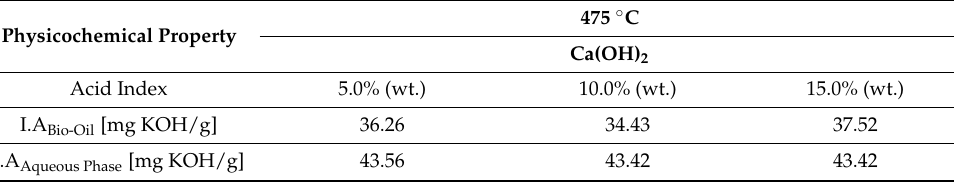
Table 12. Effect of Ca(OH) 2 content on the acid index of bio-oils and aqueous phase by catalytic cracking of MHSW fraction (organic matter + paper) at 475 ◦ C, 1.0 atm, 5.0, 10.0, and 15.0% (wt.) Ca(OH) 2 , in laboratory